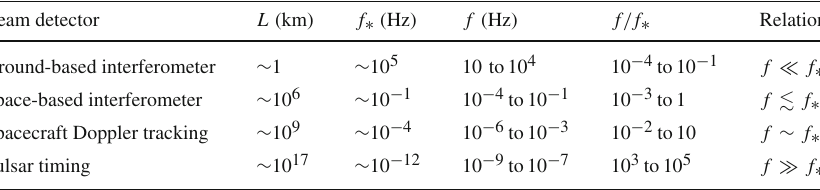
Fig. 23 A spacetime diagram representation of Δ T ( t ) for an equal-arm Michelson interferometer. Time increases vertically upward. The vertical arrows are spacetime worldlines for the beam splitter and two end mirrors. The blue dotted lines show the trajectory of the laser light in the two arms of the interferometer in the absence of a gravitational wave; the red solid lines show the trajectory in the presence of a gravitational wave. The black dotted arrows , labeled ˆ u and ˆ v , show the orientation of the two arms, from beam splitter to end mirrors, at t = 0, assuming an opening angle of 90